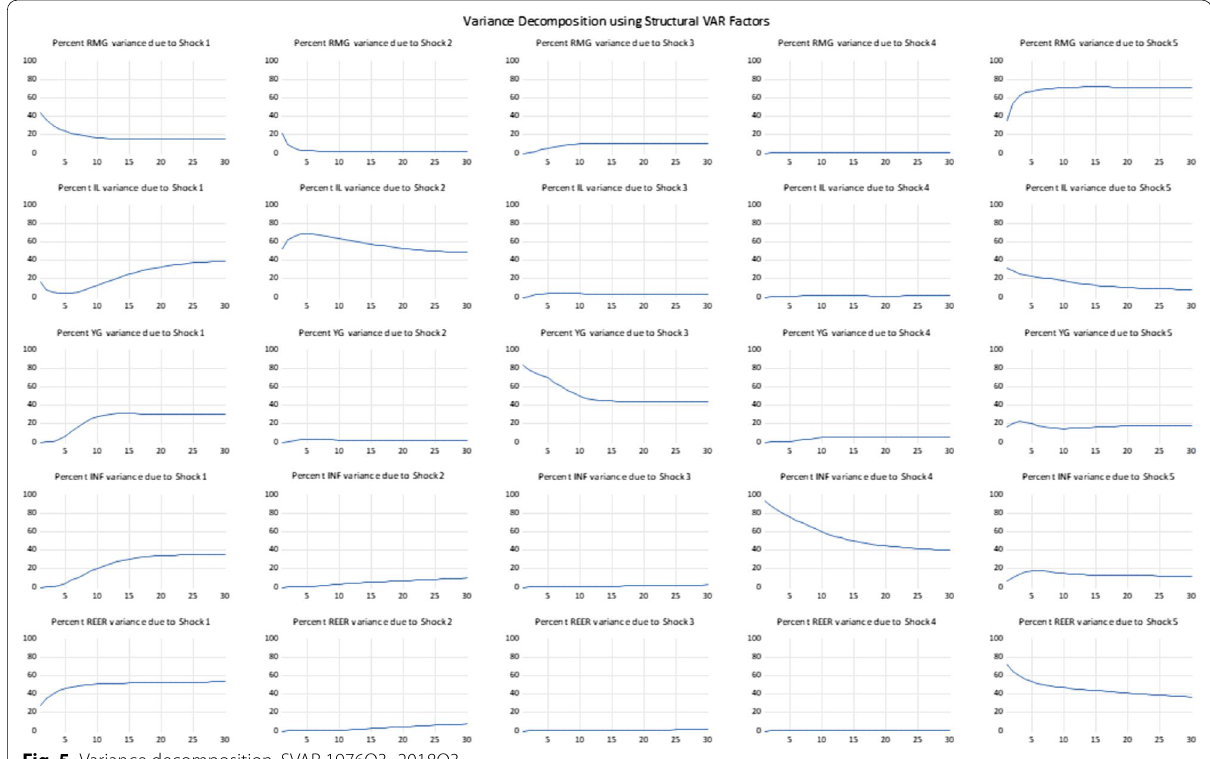
Fig. 5 Variance decomposition, SVAR